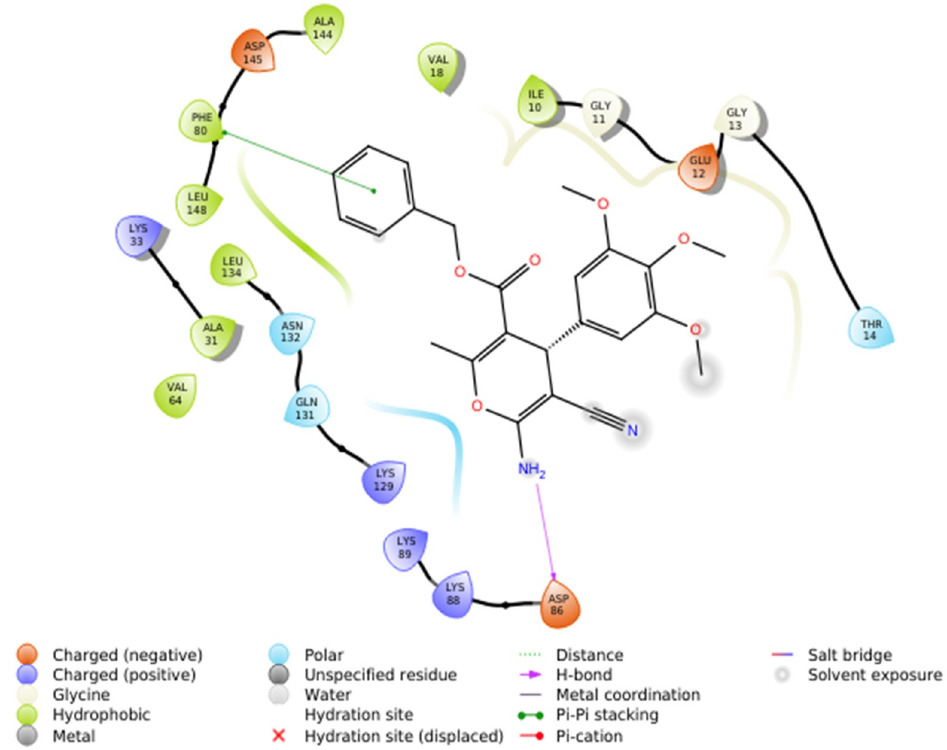
Figure 10. Two-dimensional model of binding interactions of compound 4d after docking calculations in the ATP binding pocket of CDK2. Docking pose for 4k: Likewise, the analysis of the binding interactions between CDK2 and compound 4k (Figures 11 and 12) revealed the formation of two hydrogen bonds between the amino acid residues ASP86 and LYS129 in the active pocket and amino (as a donor) and nitrile (as an acceptor) substituents of 4k . Additionally, the phenyl ring of the benzyl moiety showed lipophilic interactions with ILE10, VAL18, ILE10, PHE80, LEU148, LEU134 and VAL64.